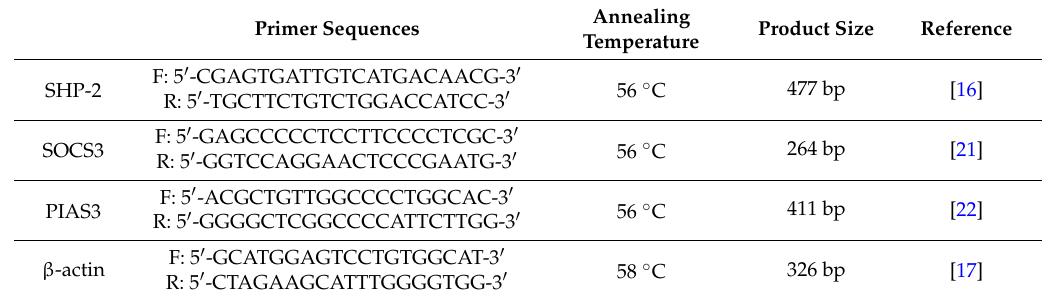
Table 1. Sequences of PCR primers for SHP-2, SOCS3, PIAS3, β -actin